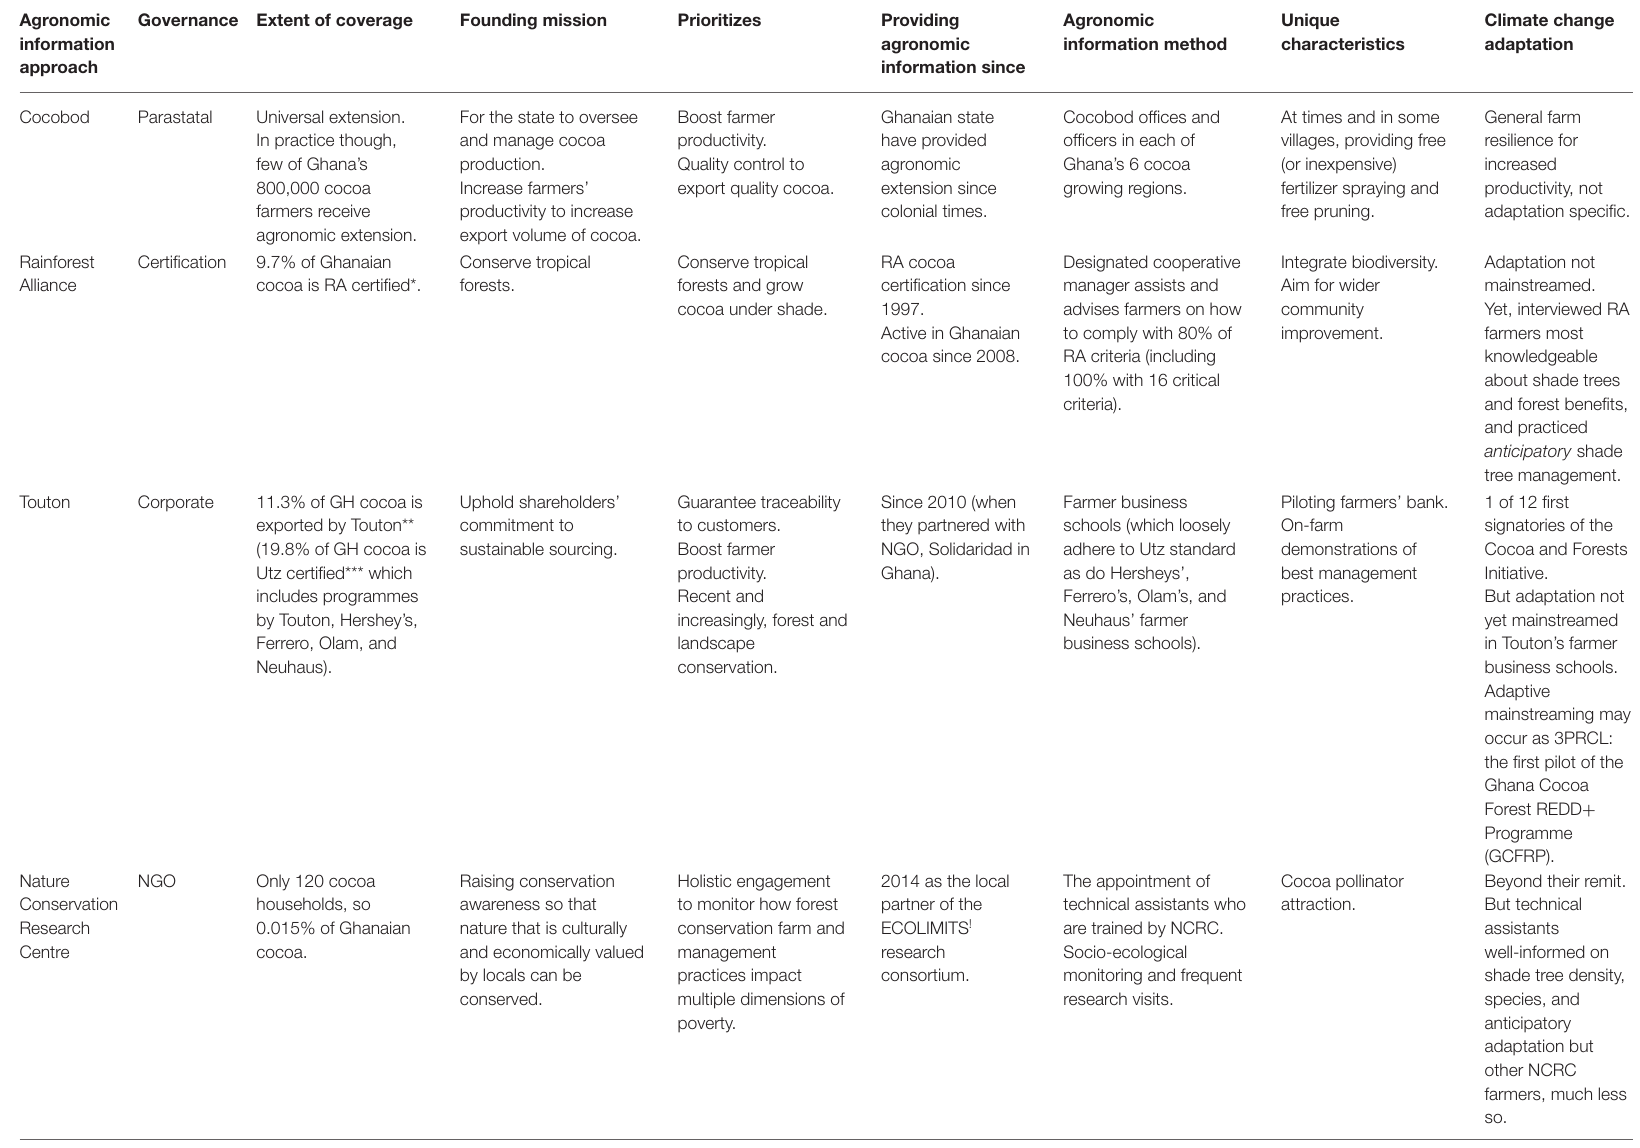
TABLE 2 | Summary of key characteristics of agricultural information sources